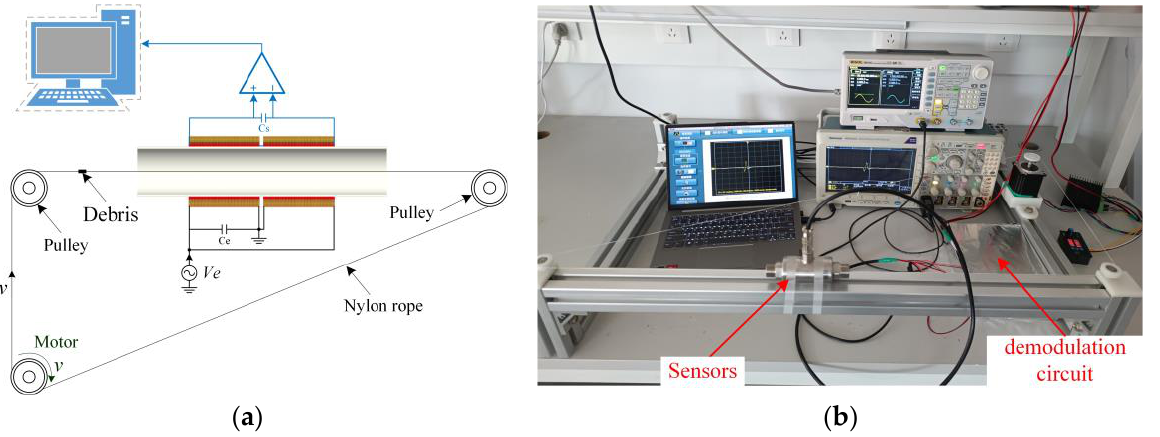
Figure 8. ( a ) Schematic diagram of the whole inspection system; ( b ) the experimental test platform.